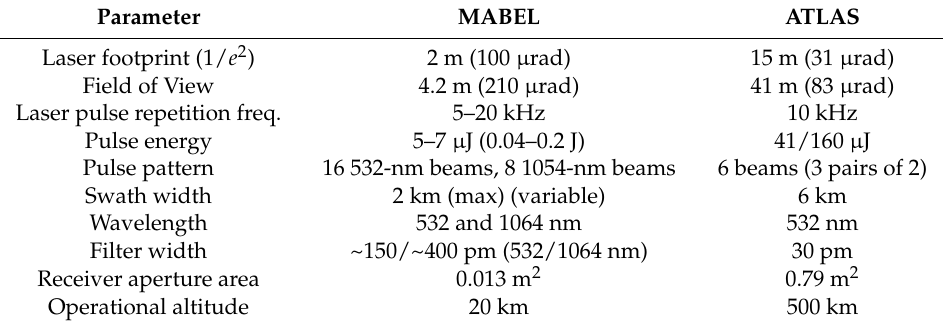
Table 5. Comparison between MABEL and future Advanced Topographic Laser Altimeter System (ATLAS) system parameters. Note: the values in parentheses in the MABEL pulse energy field denote the reclassified, “as flown” energy levels, as opposed to the original design